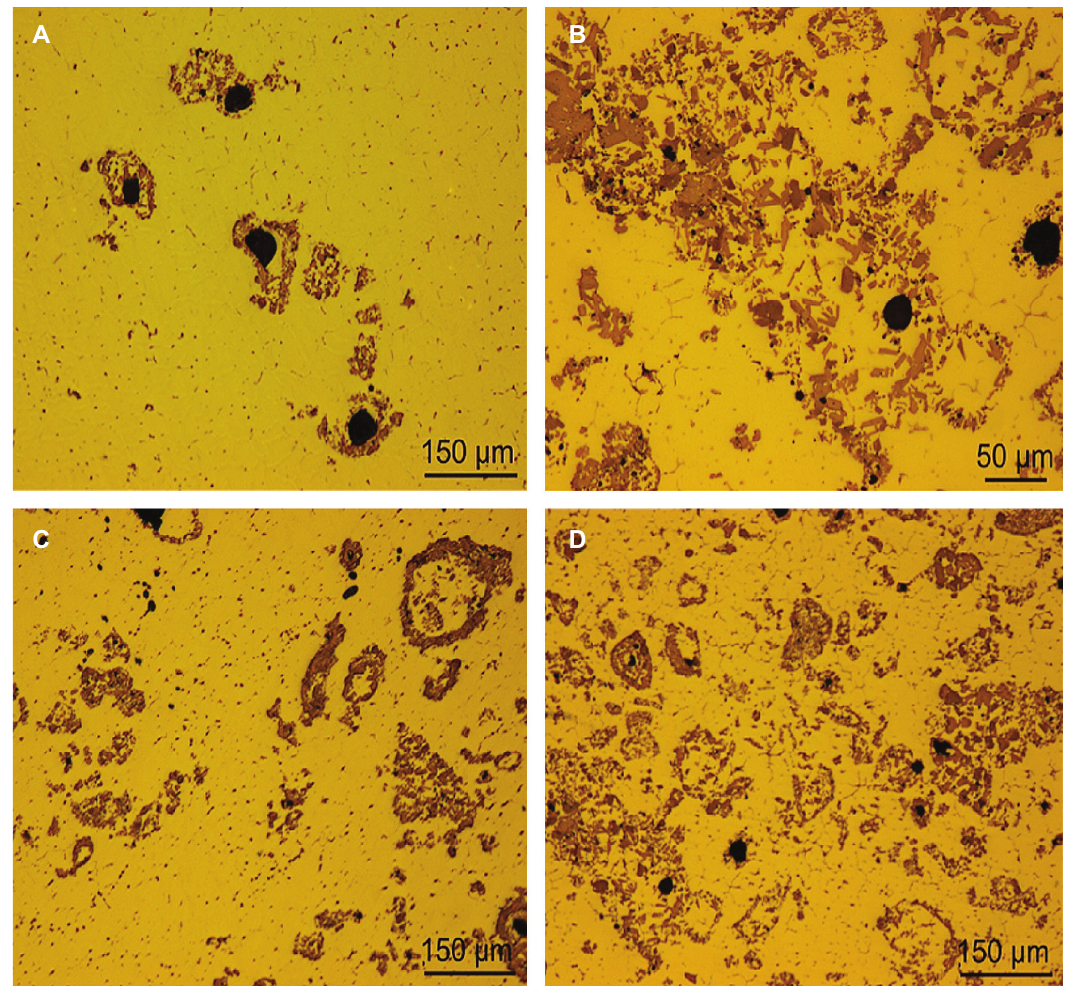
Figure 1 Optical micrographs of the composite containing different weight percents of boron: (A) 1 wt%, (B) 2 wt%, (C) 3 wt%, (D) 4 wt%.